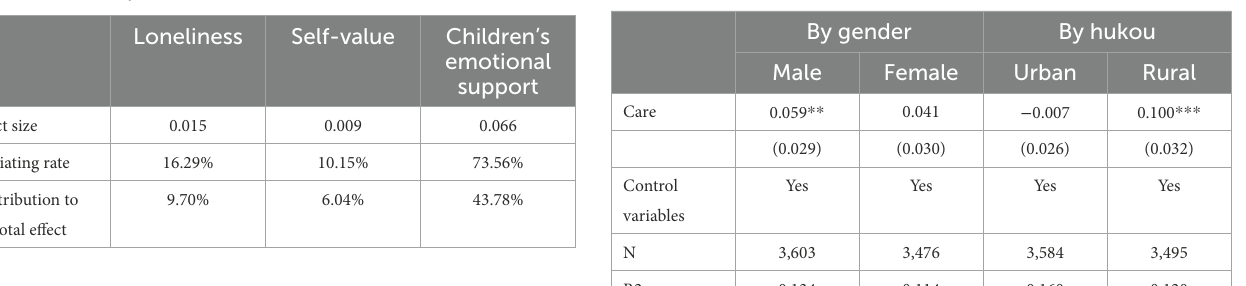
TABLE 8 KHB decomposition results. TABLE 9 Heterogeneity analysis.